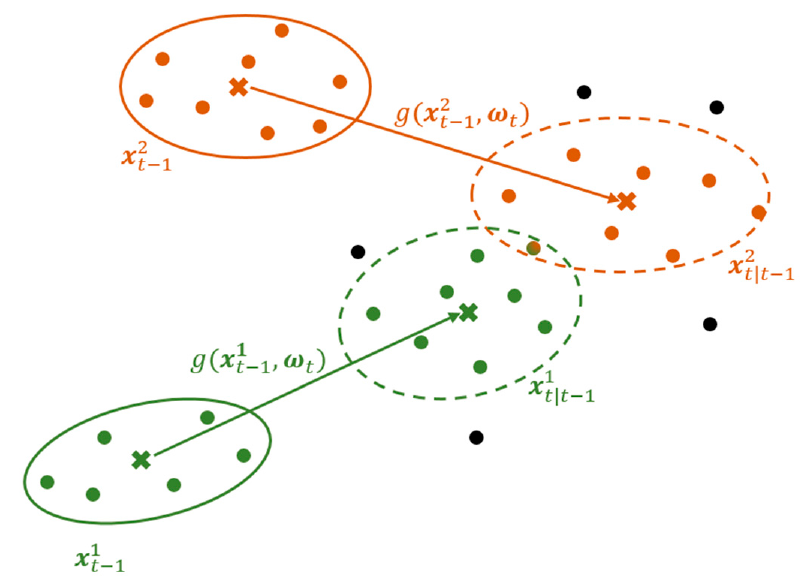
Figure 5. Visualisation of measurement validation using gating method calculated as in (3)–(5). Measurements that fall within validation regions of the two respective targets are used to calculate the dispersion matrix for the next observation step. Unvalidated ones are neglected while common ones are shared.